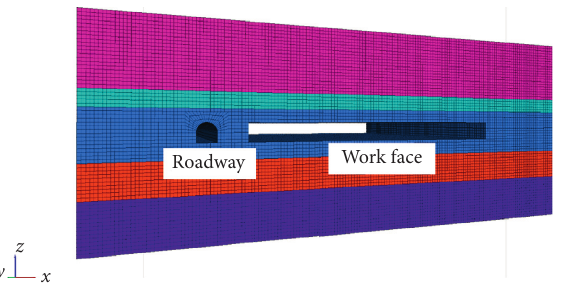
Figure 10: Influence of supporting parameters on stress